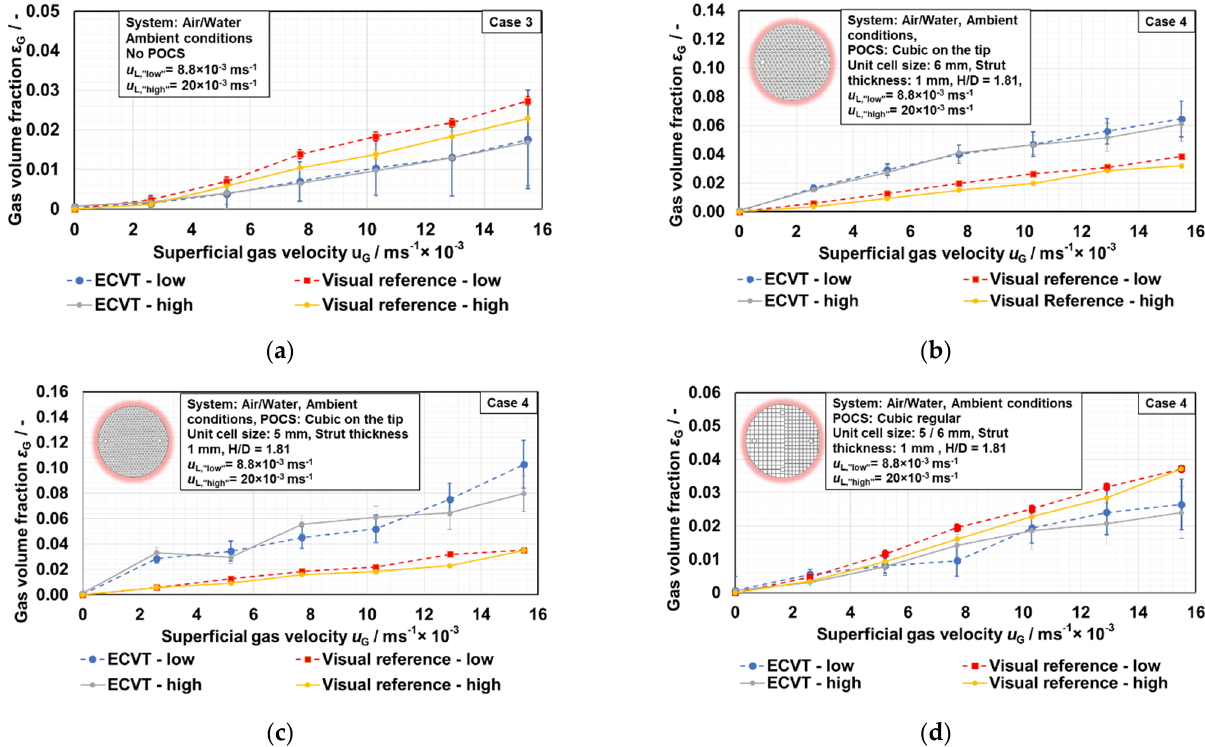
Figure 10. Case 3 and Case 4 ECVT versus visual reference for two different liquid flow rates (8.8 × 10 − 3 m s − 1 corresponds to “low” and 20 × 10 − 3 m s − 1 to “high”); ( a ) empty tube; ( b ) 6 mm cubic on the tip; ( c ) 5 mm cubic on the tip; ( d ) 5 mm/6 mm modified structure regular.